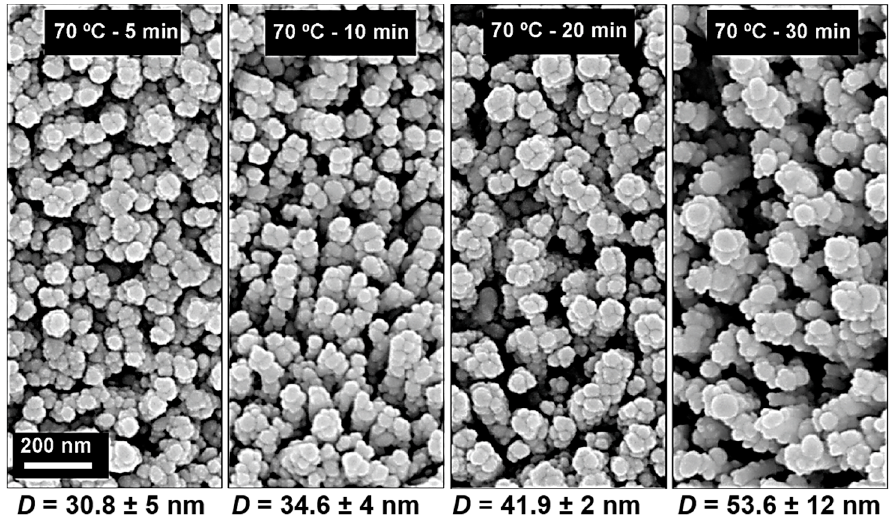
Figure 5. Scanning electron microscopy (SEM) images of ZnO nanorods (NRs) with Ag nanoparticles deposited by thermal evaporation. The NRs were produced at 70 °C with different synthesis times (5, 10, 20 and 30 min). The corresponding values of the average NP size (in-plane major axis, D ) of the Ag NPs deposited on the nanorods, from 6 nm mass equivalent thicknesses, are indicated below the images.